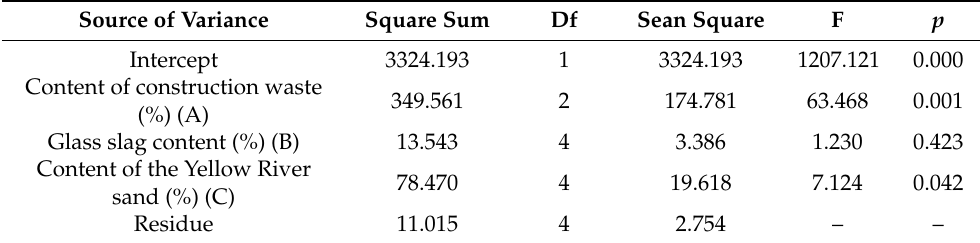
Table Note: Under the confidence interval of 95%, p < 0.05 indicates significant